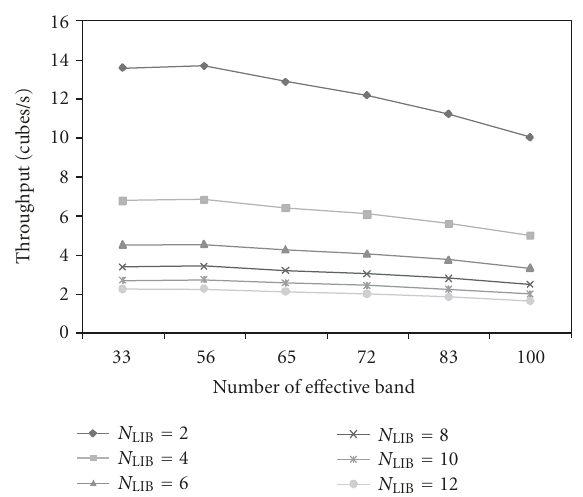
Figure 20: Illustration of throughput in the multiple-processing execution